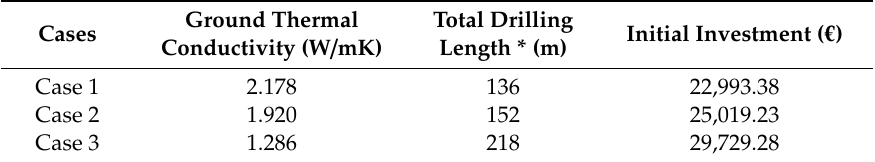
Table 5. Drilling length and initial investment required in the geothermal system of each case, according to the global ground thermal